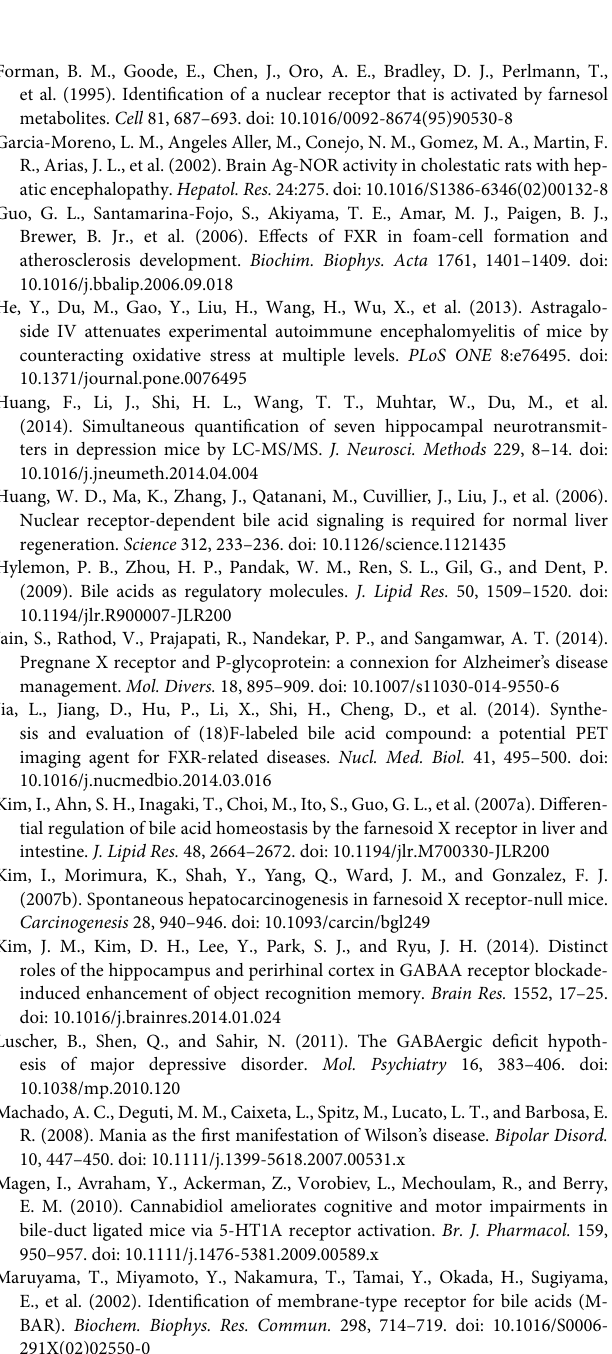
Supplementary Figure 1 | FXR mRNA expression pattern in brain of wild-type mouse. Liver served as positive